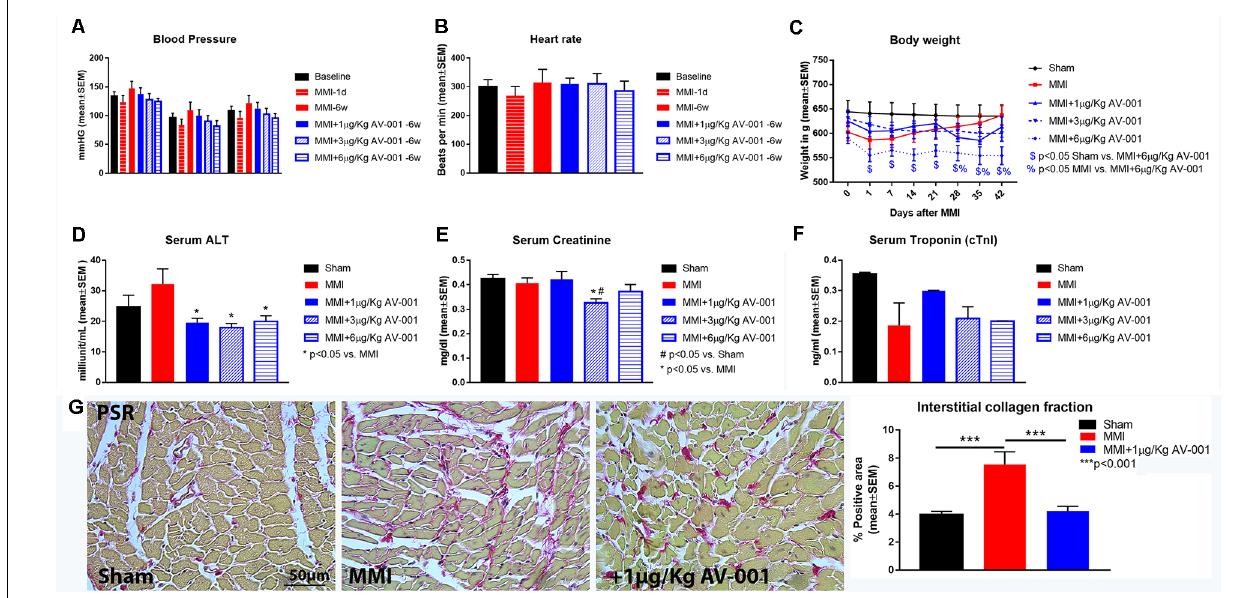
FIGURE 1 | AV-001 treatment is safe in middle-aged rats subject to MMI. (A,B) There were no significant differences in blood pressure or heart rate at 1 day or 6 weeks after MMI compared to baseline values. AV-001 treatment (1, 3, or 6 µ g/Kg) does not significantly alter blood pressure or heart rate at 6 weeks after MMI compared to baseline values or the MMI control group. (C) Treatment of MMI with 1, 3 or 6 µ g/Kg AV-001 does not significantly alter body weight at day 42 compared to baseline values before treatment initiation at 1 day after MMI. While 6 µ g/Kg AV-001 treated group exhibit significantly lower body weight compared to Sham and MMI control group, the weight difference is evident starting at 1 day after MMI before treatment was initiated and is not significantly different on day 42 compared to its baseline values at day 0 or day 1 after MMI. (D) MMI does not alter serum Alanine transaminase (ALT) levels compared to Sham group. AV-001 treatment (1, 3, or 6 µ g/Kg) significantly reduces serum ALT levels compared to the control MMI group. (E) MMI does not alter serum creatinine levels compared to Sham group. Treatment with 3 µ g/Kg AV-001 significantly reduces serum creatinine levels compared to the control MMI group. (F) Serum Troponin I (cTnI) levels were within normal range for Sham, MMI, and AV-001 treatment (1, 3, or 6 µ g/Kg) groups at 6 weeks after MMI. (G) MMI significantly increases fibrosis within the heart as indicated by increased interstitial collagen compared to sham rats. 1 µ g/Kg AV-001 treatment significantly reduces collagen in the heart compared to untreated MMI